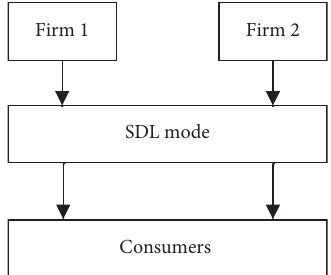
Figure 1: Logistics mode with SDL.